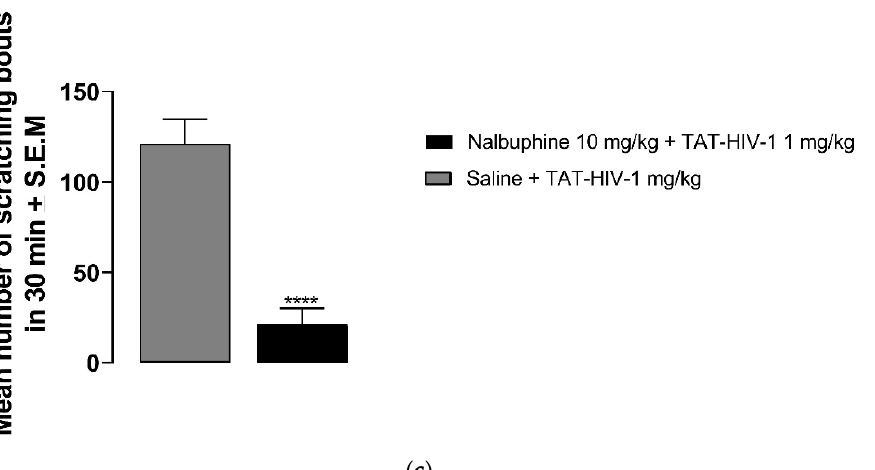
Figure 2. Subcutaneous behind the neck injection of TAT-HIV-1 induces scratching in a dose-dependent manner. Panel ( a ) Mice were administered saline (s.c., flank area) and then 30 min later they were injected with either saline or TAT-HIV-1 (0.1–1 mg/kg, behind the neck). One min following injections, the number of scratching bouts was counted for 30 min. Both TAT-HIV-1 at 0.3 and 1 mg/kg elicited scratching significantly compared to saline (one-way ANOVA followed by Dunnett’s multiple comparison; *** p < 0.001, **** p < 0.0001; n = 6). Nalbuphine inhibits TAT-HIV-1-induced scratching in a dose-dependent manner. Panel ( b ) Nalbuphine at 3 and 10 mg/kg doses inhibited scratching elicited by submaximal dose of TAT-HIV-1 (0.3 mg/kg) significantly compared to control (one-way ANOVA followed by Dunnett’s multiple comparison; * p < 0.05, ** p < 0.01; n = 6). Nalbuphine at 10 mg/kg also alleviated scratching induced by maximum dose of TAT-HIV-1 (1 mg/kg). Panel ( c ) (unpaired Student’s t -test; **** p < 0.0001; n = 6). Swiss–Webster mice were used for these studies.